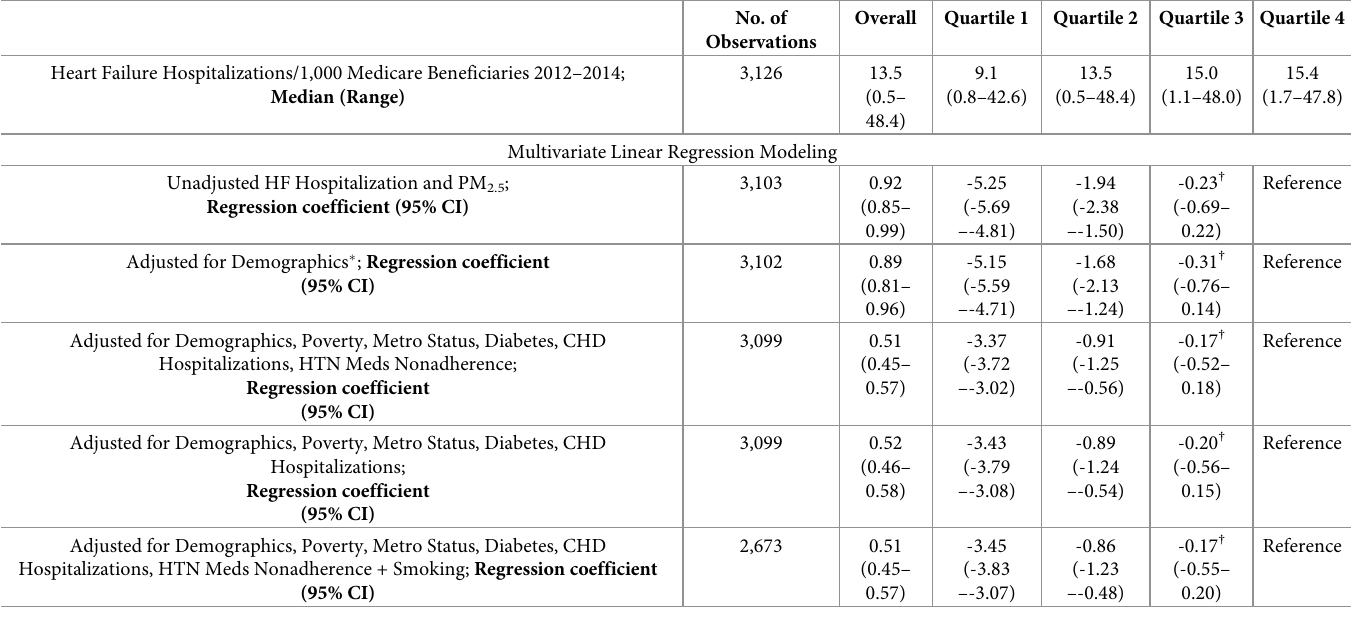
Table 3. HF hospitalizations analytic-weighted multivariate linear regression